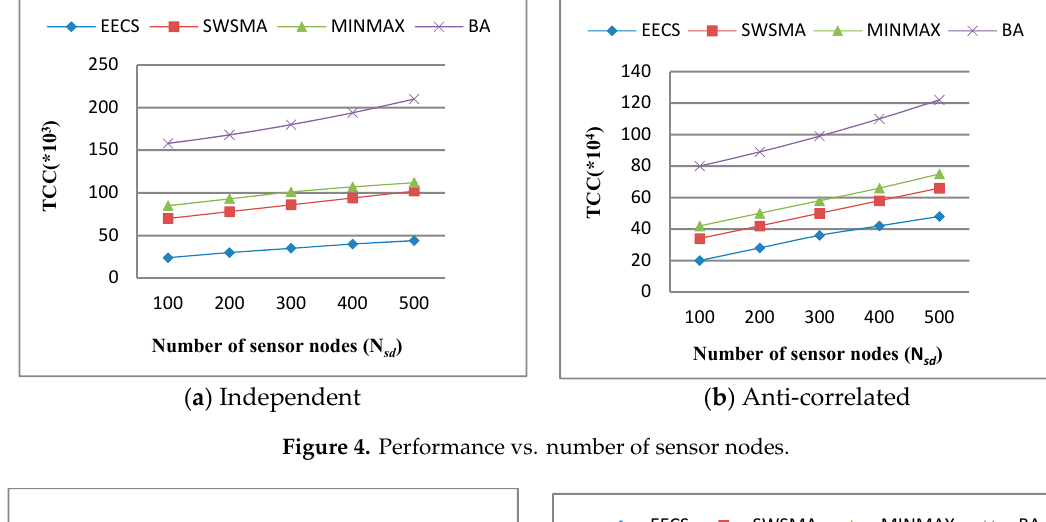
Figure 4. Performance vs. number of sensor nodes.